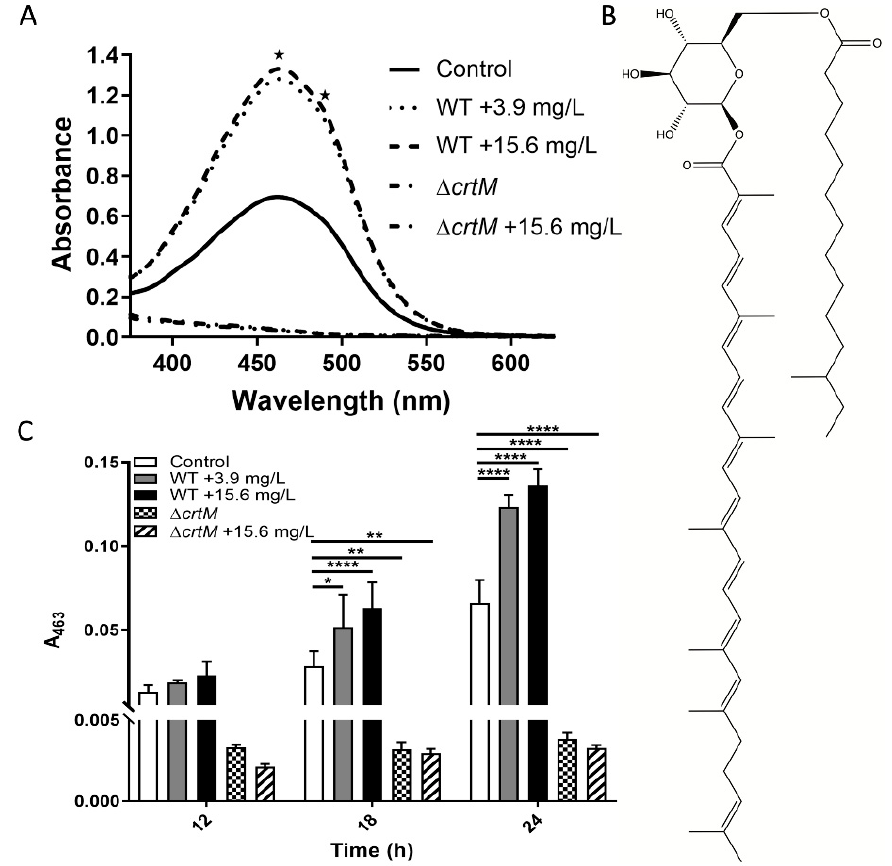
Figure 1. Staphyloxanthin (STX) Pigment Production post-Treatment with GRA. ( A ) Visible scans at 24 h reveal an overall increase in pigment with GRA treatment of WT MRSA bacteria and lack of pigment in the ∆ crtM mutant strain that does not produce staphyloxanthin (STX). STX displays characteristic absorbance signals at 463 and 490 nm as indicated by the two asterisks. ( B ) Chemical structure of STX. ( C ) STX production was significantly higher at 18 and 24 h post-treatment with GRA in the WT MRSA strain compared to the untreated control, and absent in the ∆ crtM mutant strain. Significance was established based on one-way ANOVA with Sidak post hoc test (* p ≤ 0.05, ** p ≤ 0.01, **** p ≤ 0.0001).